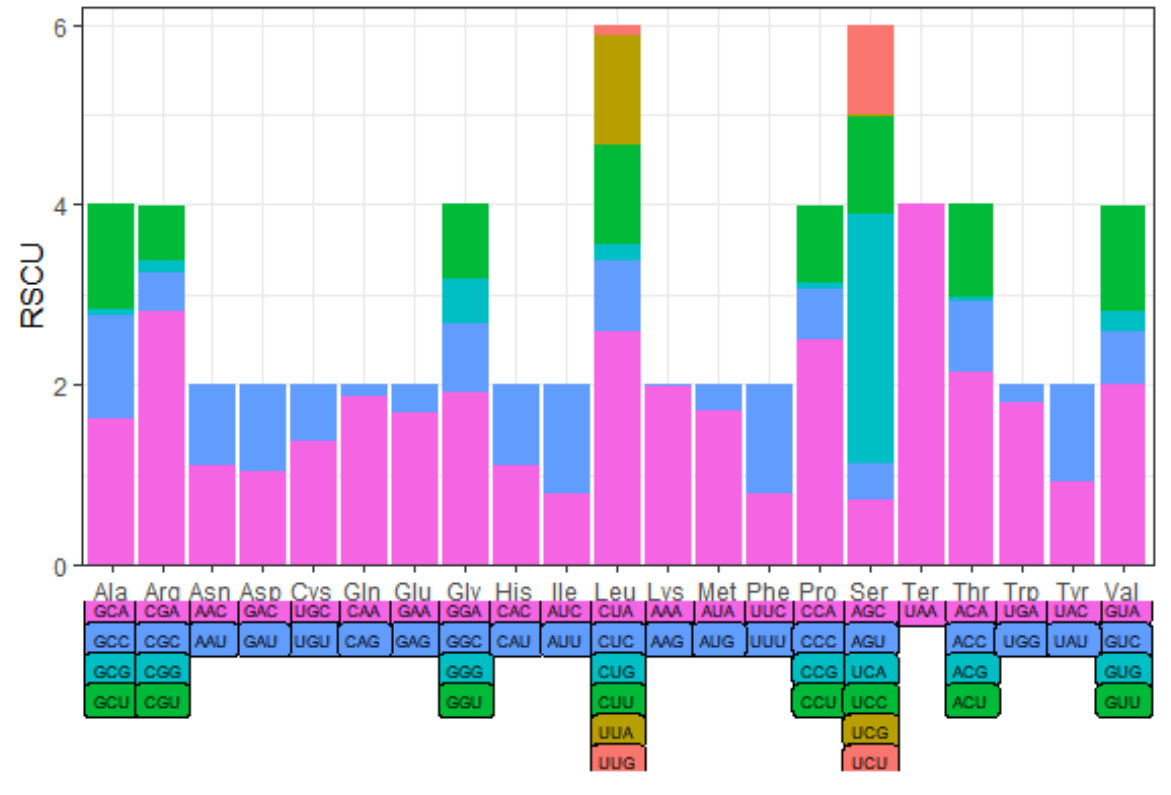
Asterisk “*” indicates that it is a stop codon and has no corresponding amino acid.